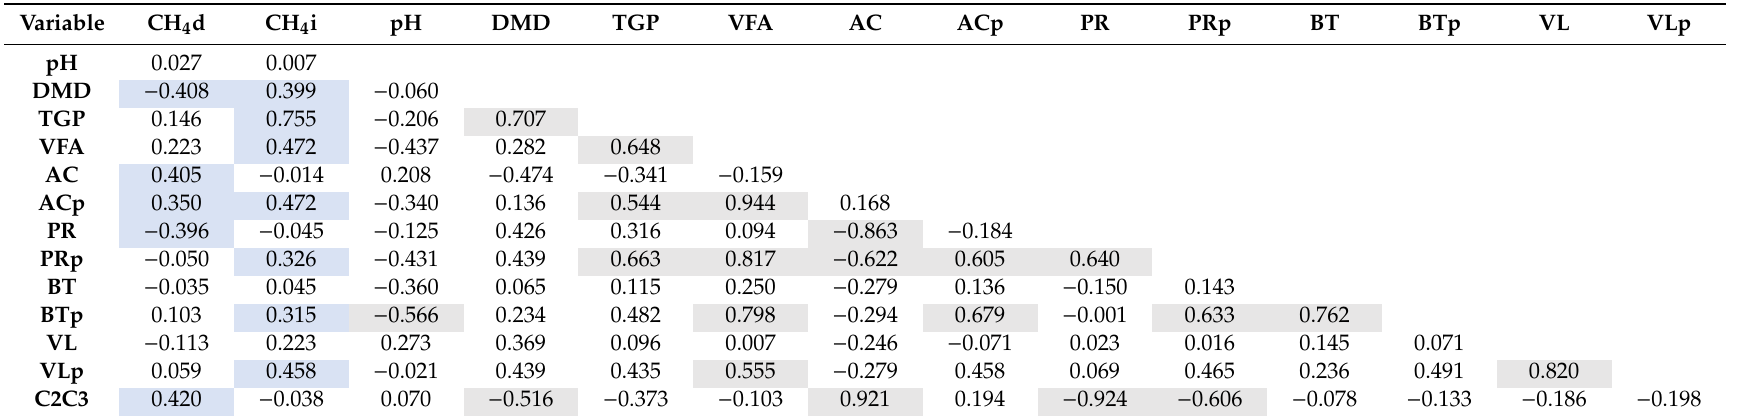
− 0.606 − 0.078 − 0.133 − 0.186 −